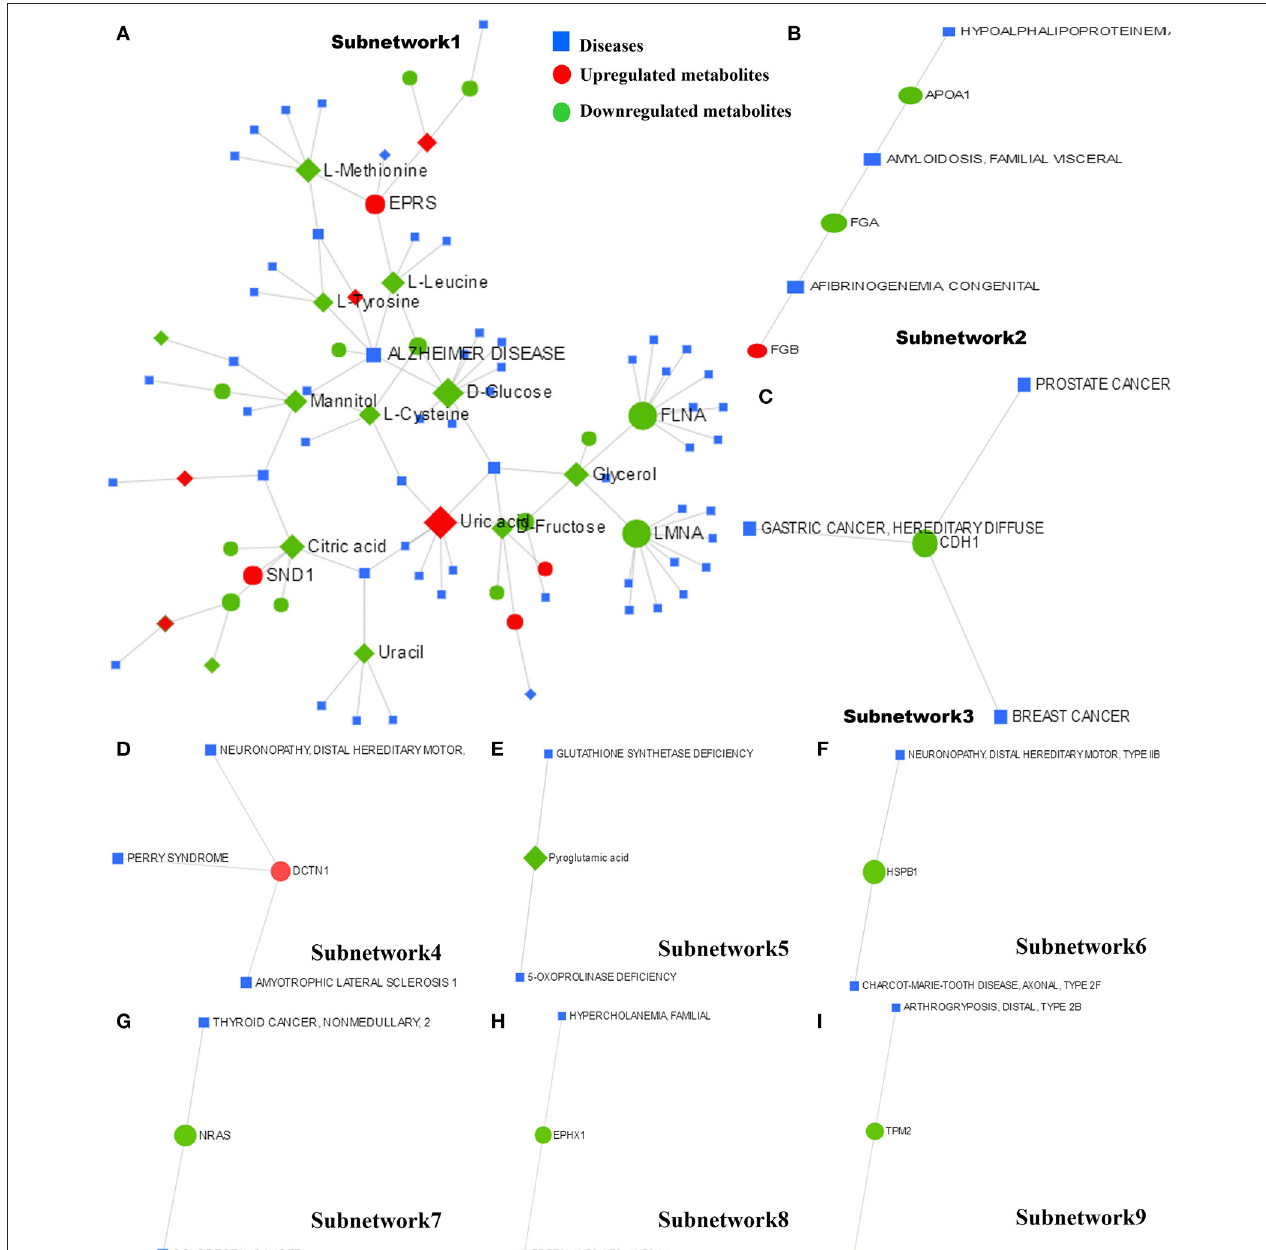
FIGURE 8 | The metabolite–protein–disease interaction network provides a global view of the potential functional relationships between metabolites, connected proteins identified from proteomics and metabolomics and target diseases. The nine subnetworks are indicated in (A–I) , respectively.